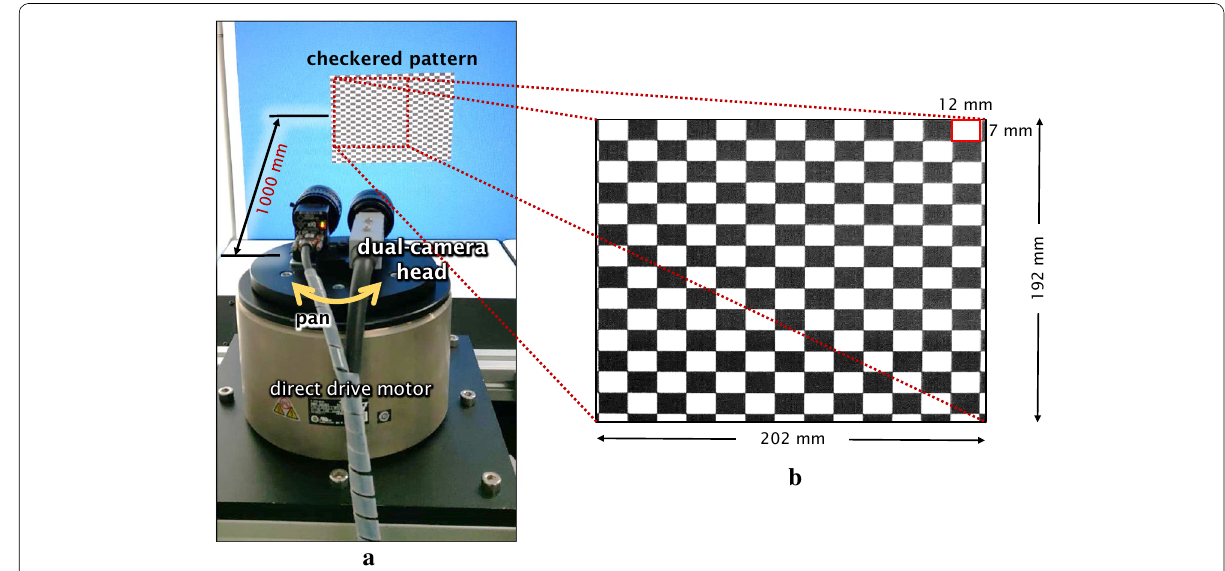
Fig. 4 Experimental setup for observation of a checkered pattern a overview, b checkered